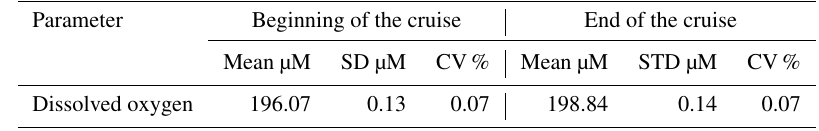
Table 5. Precision of dissolved oxygen (SD is standard deviation, and CV is coefficient of variation). Parameter